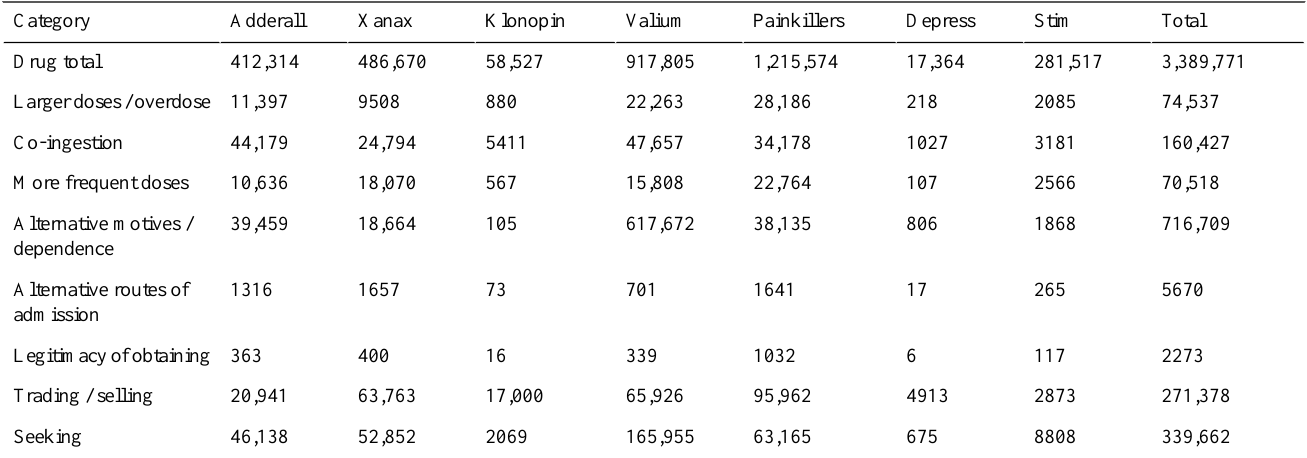
Table 3. Number of prescription drug tweets by drug